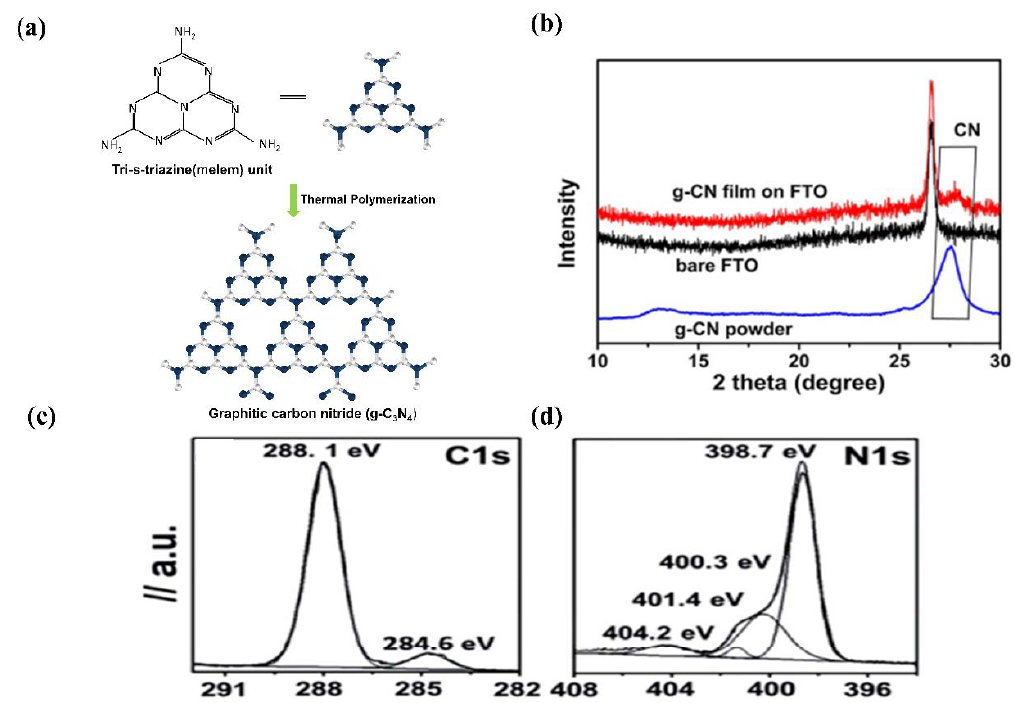
Figure 3. ( a ) Schematic structure of a g − CN constructed from tri-s-triazine units. ( b ) XRD pattern of g − CN film. Reprinted with permission from ref. [34] Copyright 2015 Wiley-VCH. ( c , d ) XPS high- resolution spectra of the C1s and N1s core energy spectra of g − CN film. Reprinted with permission from ref. [36] Copyright 2012 Elsevier.